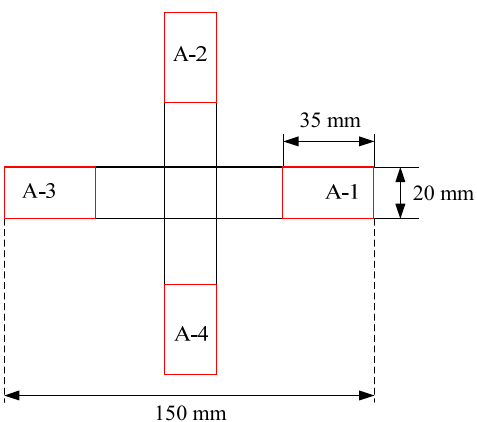
Figure 22. Schematic diagram of the F-DS.